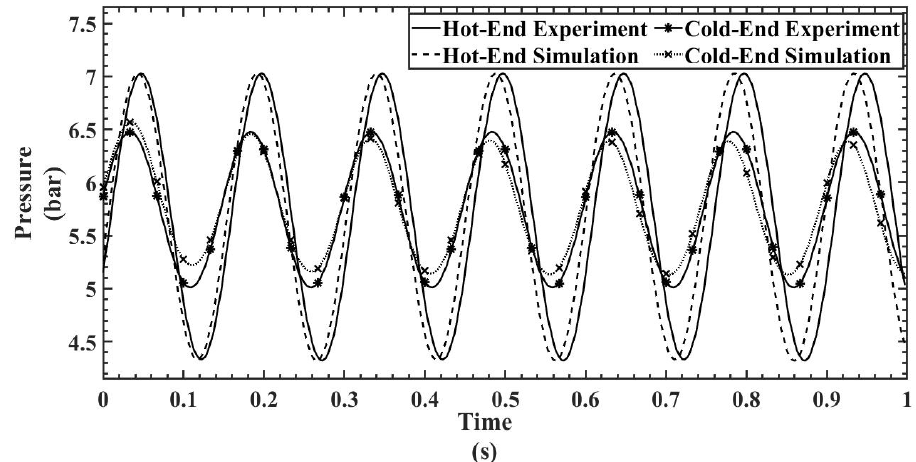
Figure 11. Hot- and cold-section pressure characteristics of a 300 mesh regenerator at 400 RPM.